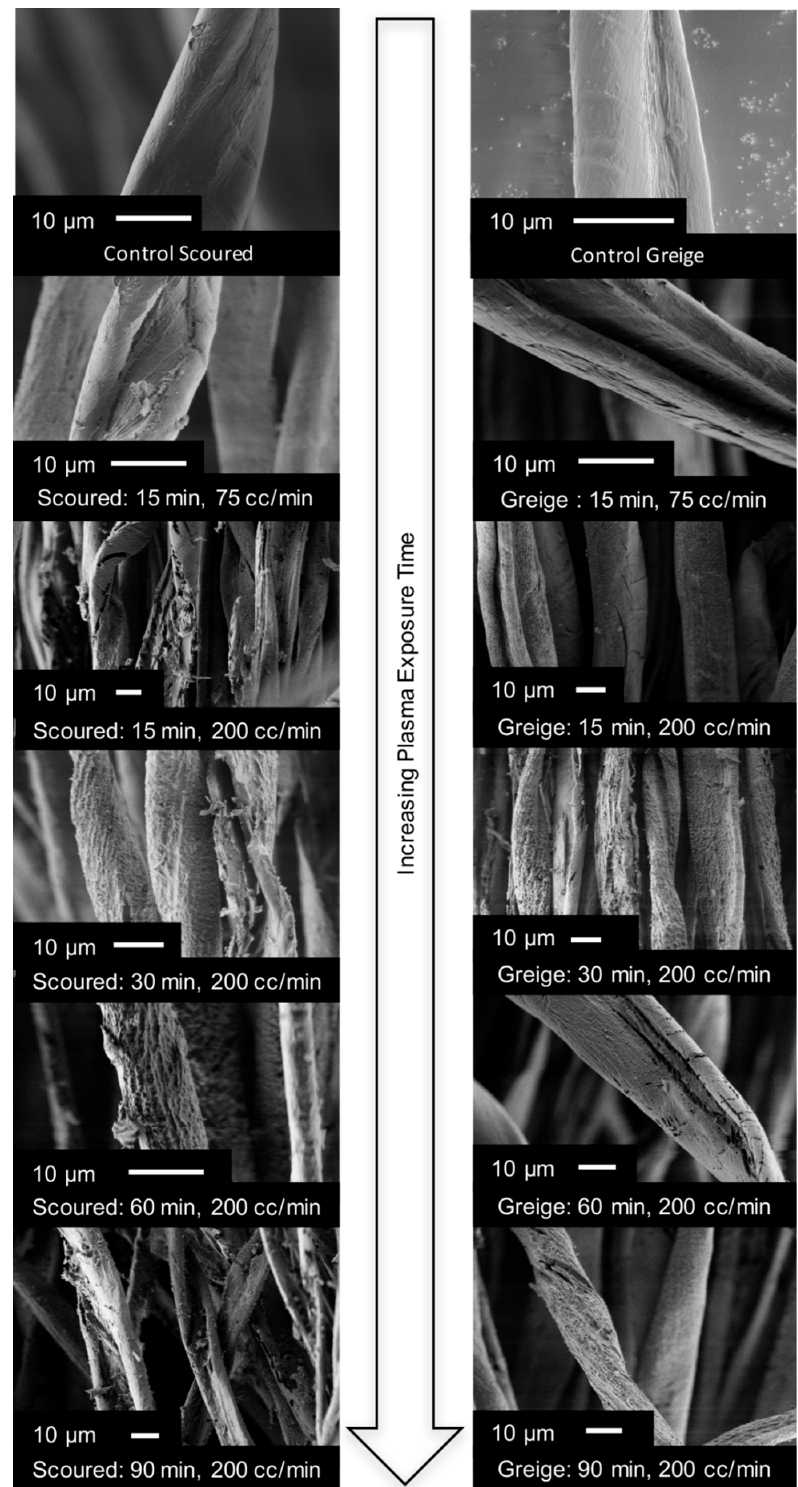
Figure 2. ( left ) Field Emission Scanning Electron Microscopy (FE-SEM) images of scoured yarn treated at 75 cc/min and 200 cc/min oxygen flow rate and 0.46 W/cm 2 power density, with increasing exposure time ( right ) FE-SEM images of greige yarn treated at 75 cc/min and 200 cc/min oxygen flow rate and 0.46 W/cm 2 power density, with increasing exposure time.